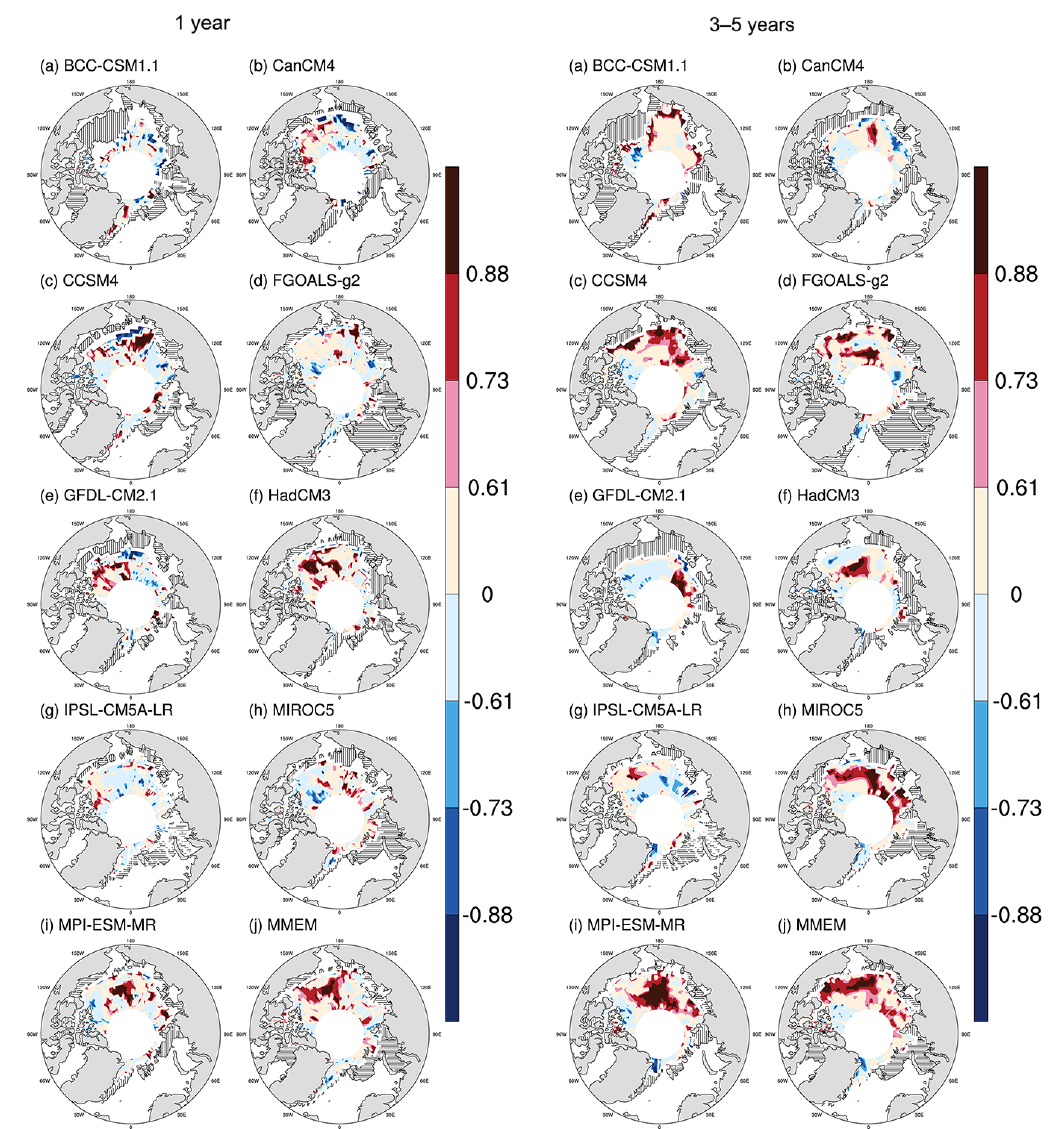
Figure 14. Anomaly correlation coefficients between the simulated and observed Arctic September sea ice concentration anomalies for the lead time of 1 year (left panel) and 3–5 years (right panel). The correlation coefficients of 0.61, 0.73, and 0.88 represent 90, 95, and 99% confidence levels, respectively. Horizontal lines depict the areas where the model simulation has sea ice, whereas the observation does not have sea ice. The opposite is the case for vertical